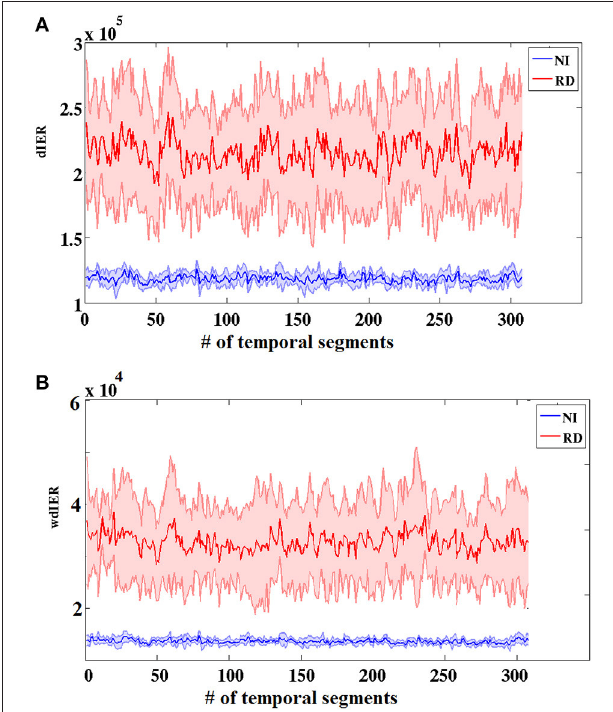
FIGURE 7 | Group-averaged dynamic (dIER; A) and weighted dynamic (wdIER; B) Information Exchange Rate showing significant differences between the RD and NI groups (Wilcoxon score, p < 10 − 11 ). Value sums over the entire network (between every possible pair of sensors) are shown on the vertical axis. Thinner lines indicate ± 1 SD